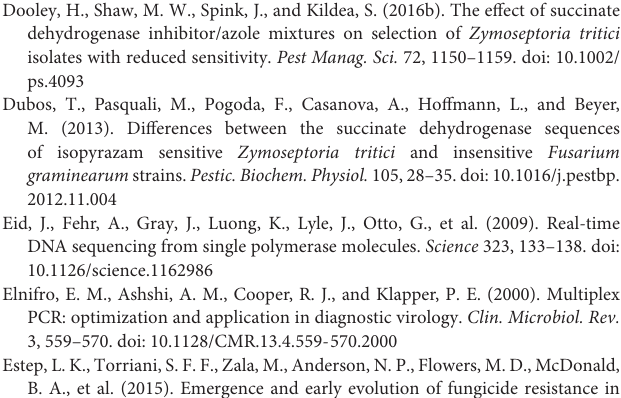
Supplementary Table 2 | Summary of SNP markers in housekeeping genes. Supplementary Table 3 | Nucleotide sequences of reference genes in FASTA